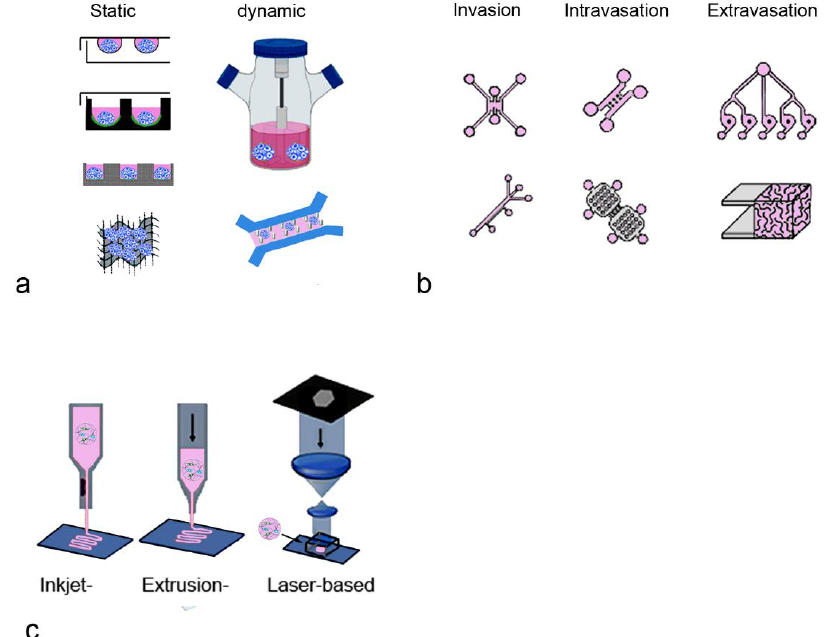
Figure 3. Examples of the production of BC models are shown. ( a ) Static (hanging drop, ultra-low attachment, micropatterned plates, scaffolds) and dynamic methods (spinner flask, microfluidic system) to generate spheroids [86]; ( b ) microfluidic systems with different geometries depending on the studied process [89]; ( c ) models produced by various printing techniques [90].